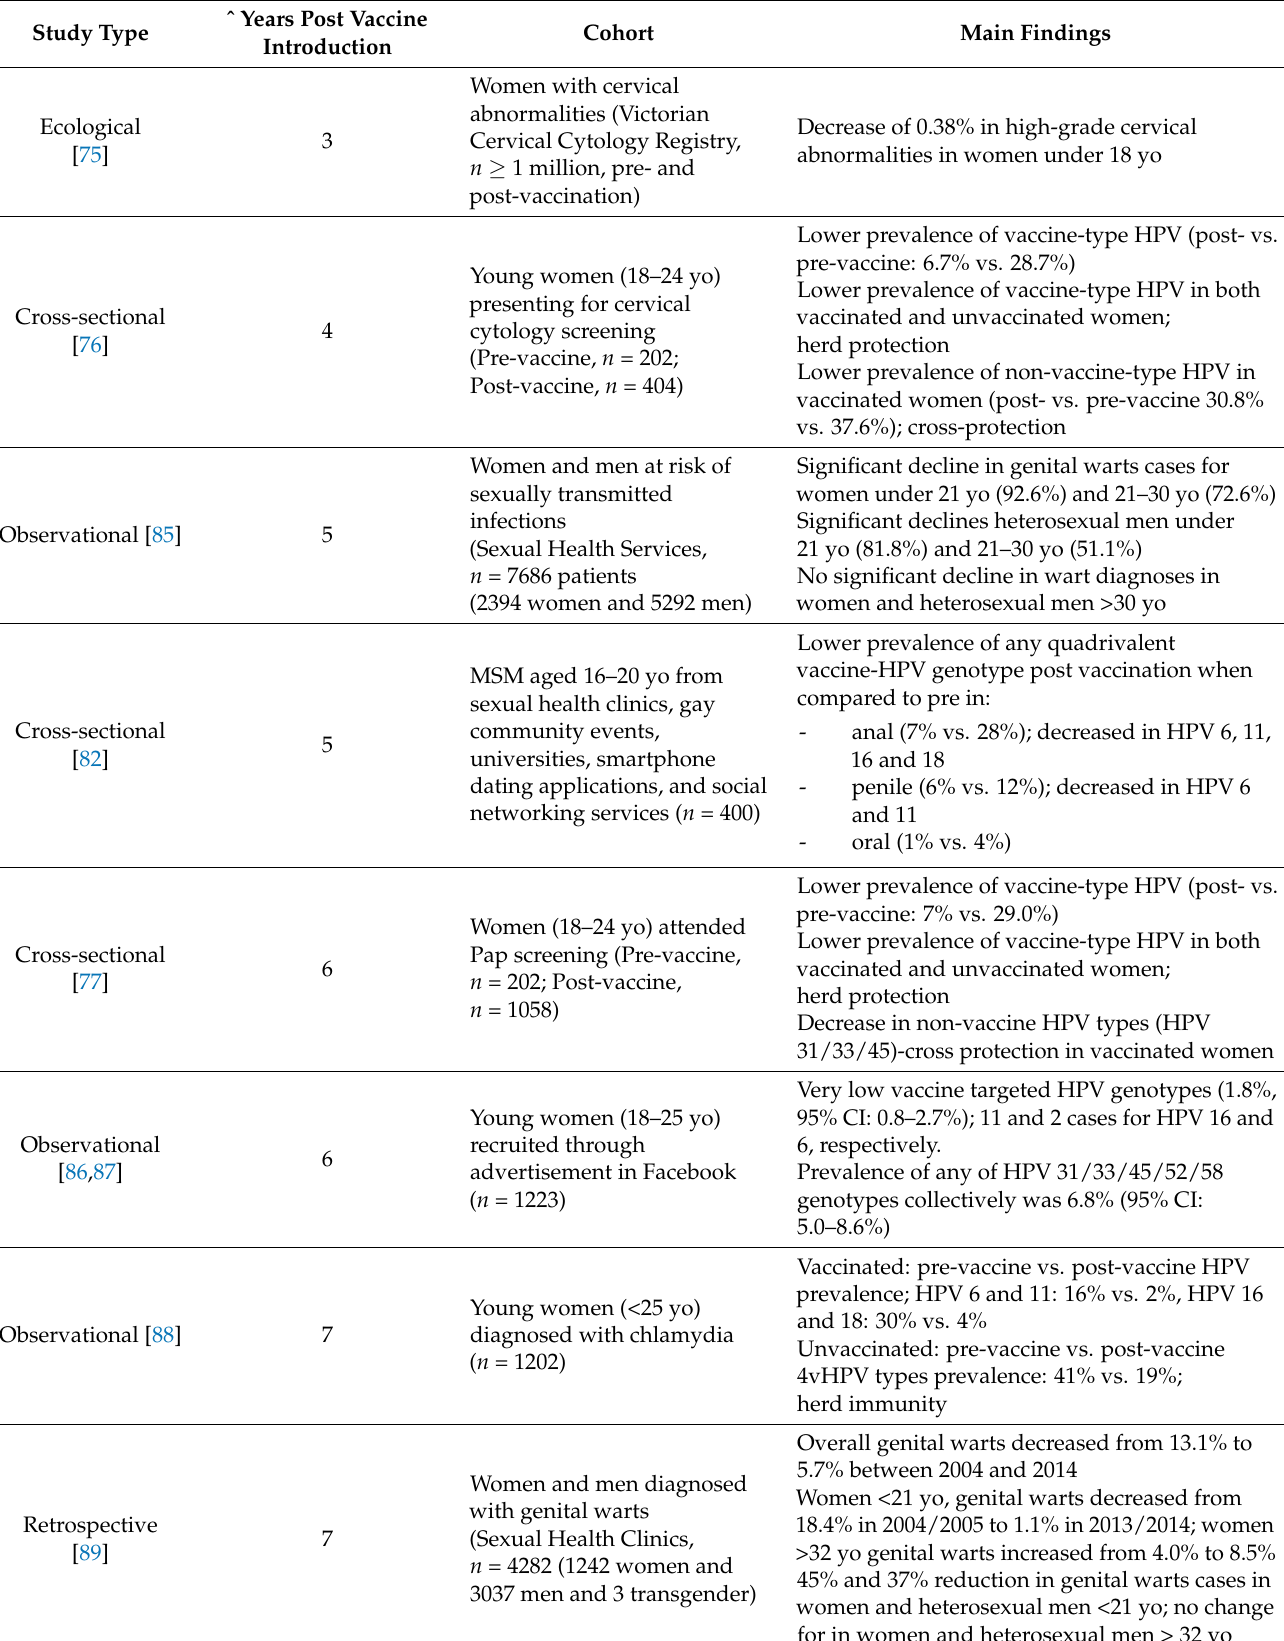
Table 6. HPV vaccine impact studies in